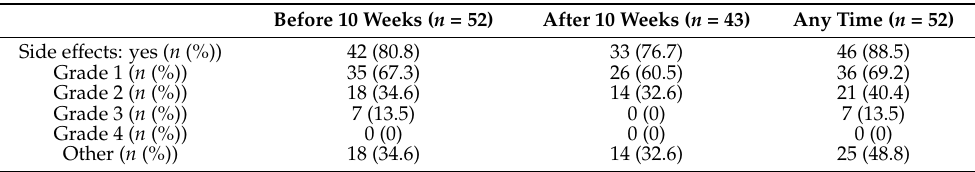
Table 4. Side effects in the experimental (imiquimod)